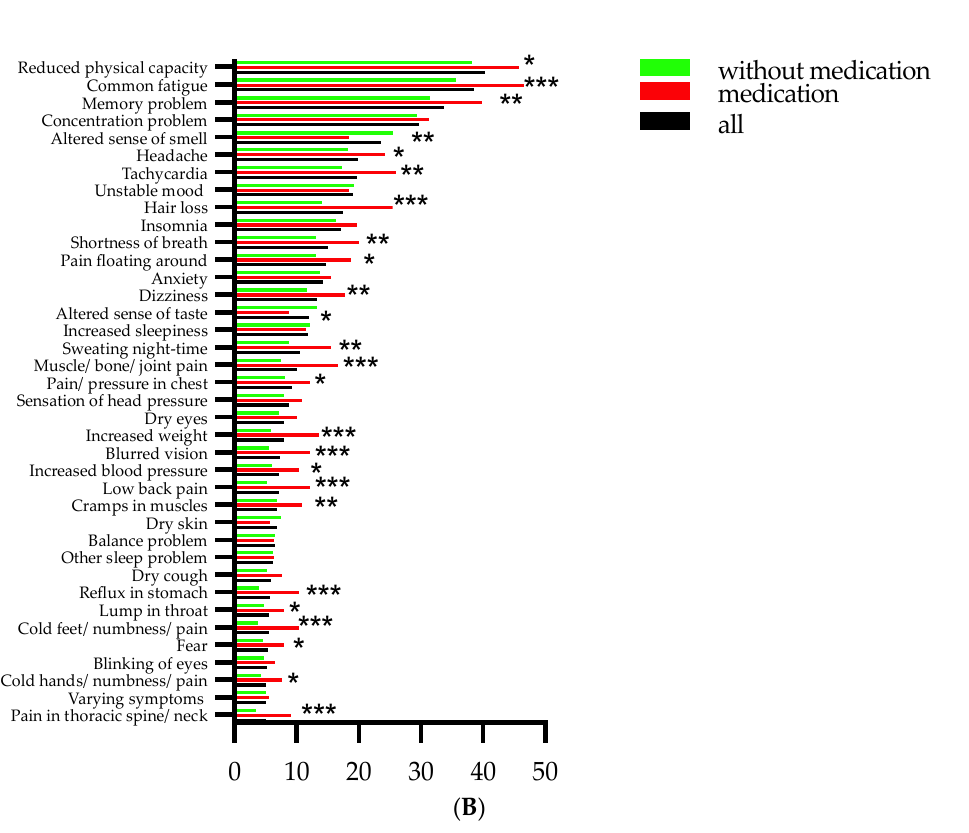
Figure 2. Persistent symptoms in 1050 participants. Panel ( A ) presents percentages of healthy participants (green) and with chronic disease (red) reporting any persistent symptom. Panel ( B ) presents percentages of participants without (green) and with medication (red) reporting any persistent symptom. Statistically significant differences are indicated between healthy and with chronic disease (panel ( A )) and between participants with and without medication (panel ( B )) prior to acute infection. * p < 0.05, ** p < 0.01, and *** p < 0.001 (Chi-square test).